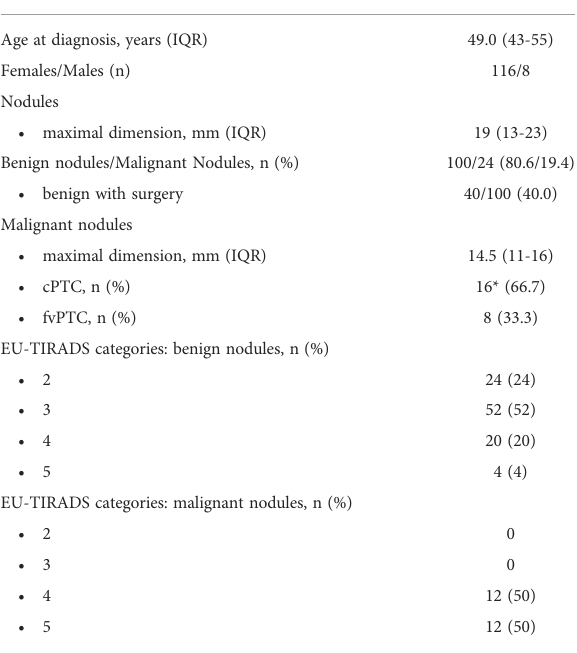
TABLE 1 Main characteristics of participants in the study (n: 124).